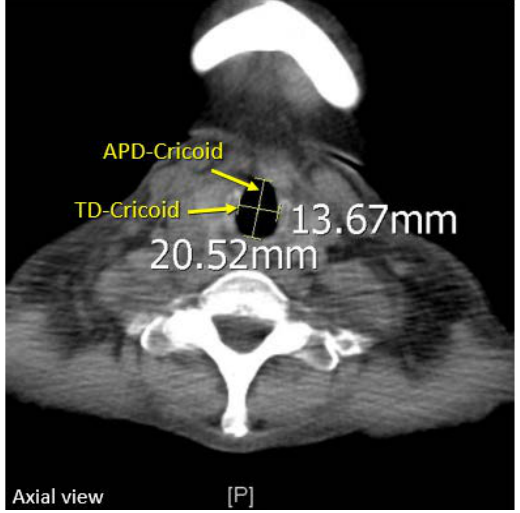
Figure 2. Measuring of the patient’s TD-Cricoid and APD-Cricoid, performed at the lower border of the cricoid cartilage on chest CT.